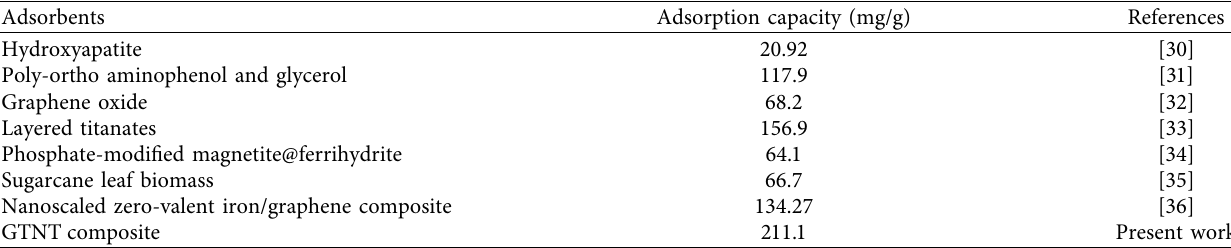
Table 3: The comparison of the Co(II) adsorption capacity of different adsorbents.